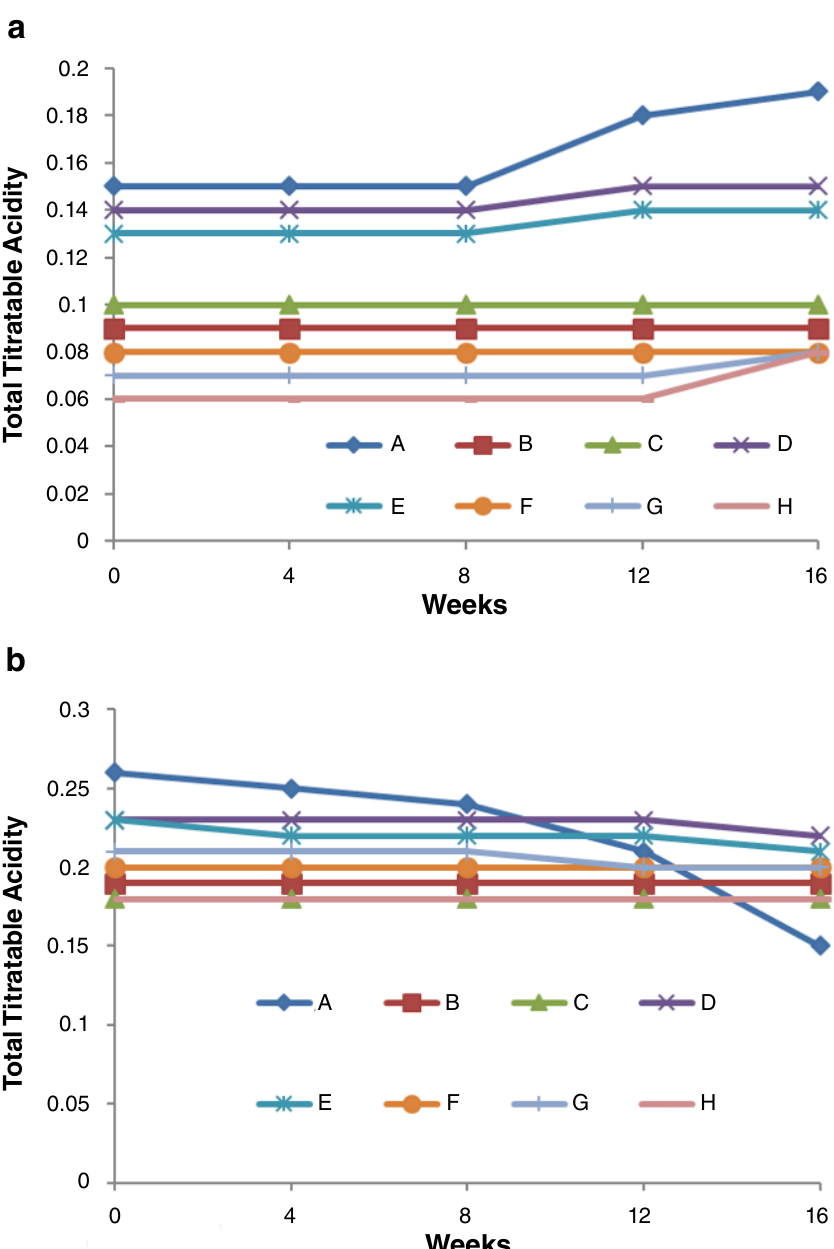
Figure 2. Titratable acidity Ogi flour made with ( a ) maize and ( b ) sorghum with Garlic and Ginger. Sample codes: A: Ogi Flour, B: Ogi Flour + 2% Garlic, C: Ogi Flour + 4% Garlic, D: Ogi Flour + 2% Ginger, E: Ogi Flour + 4% Ginger, F: Ogi Flour +2% Garlic + 2% Ginger, G; Ogi Flour+2% Garlic + 4% Ginger, H: Ogi Flour +4% Garlic + 2% Ginger.